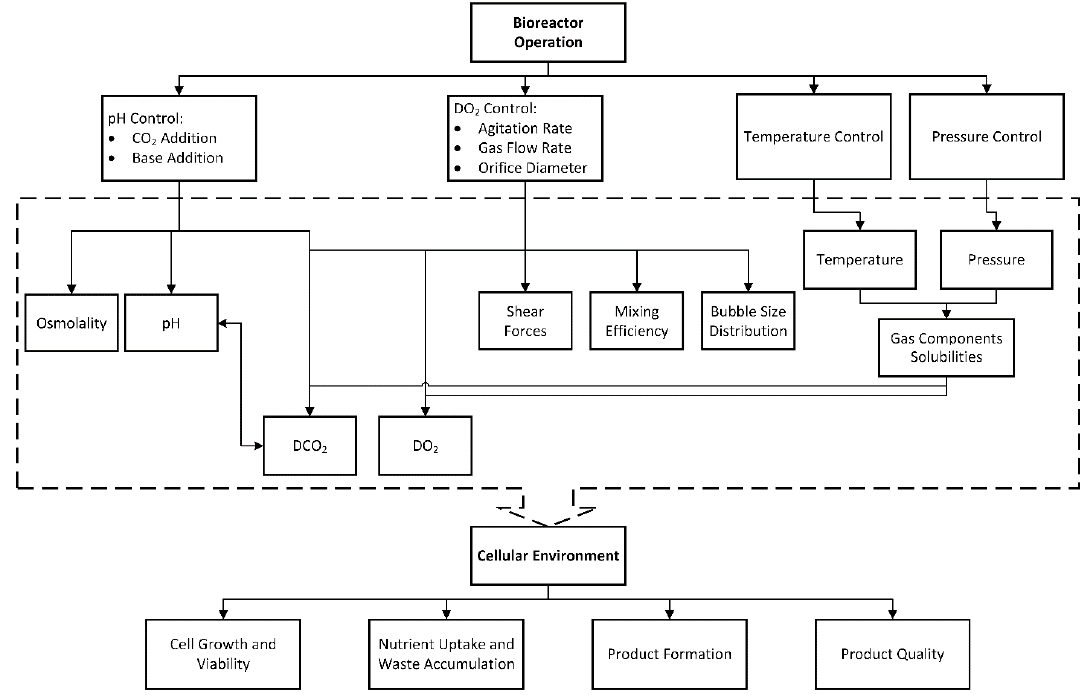
Figure 1. Cause and effect diagram for the operation of a bioreactor.